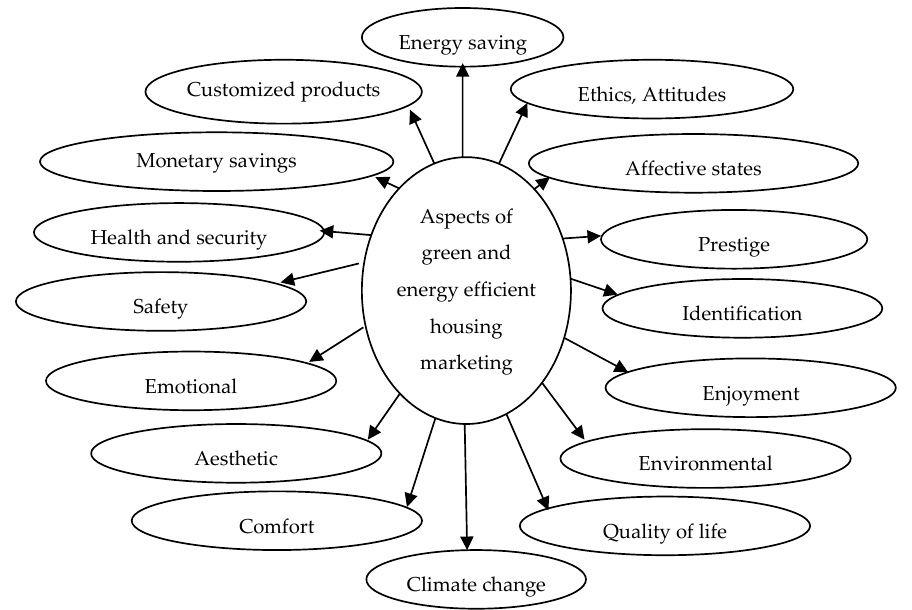
Figure 1. Quantitative and qualitative aspects of green and energy efficient marketing for analyzing the life cycle of a built environment.